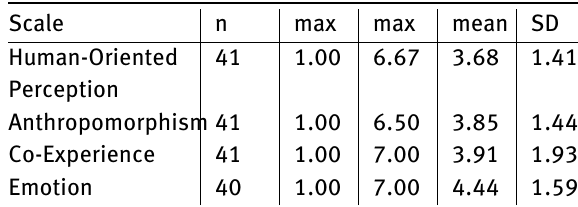
Table 8: Number of participants, minimum, maximum, mean, and the standard deviation of the score for each scale of the UX-